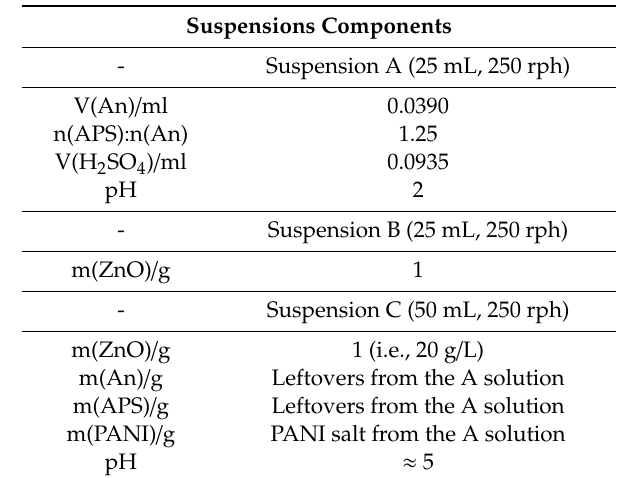
Table 5. Components used to prepare PANI / ZnO_1, PANI / ZnO_2, and PANI / ZnO_3-based multiphase composites. The first step, (i.e., PANI salt homopolymerization) was conducted in acidic Solution A, whilst the second step (in situ composite preparation) was carried on in low acidic Solution